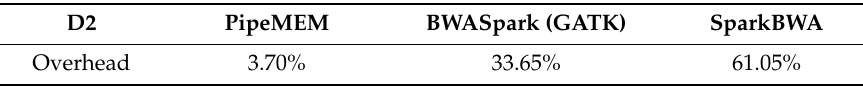
Table 7. Overhead of PipeMEM, BWASpark, and SparkBWA.